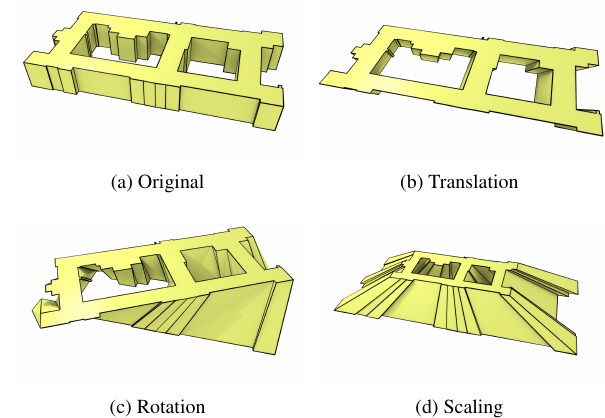
Figure 5: Applying transformations to the top face of (a) a prism results in: (b) a parallelepiped in the case of a translation, (c) a twisted prism in the case of a rotation, and (d) a frustum in the case of